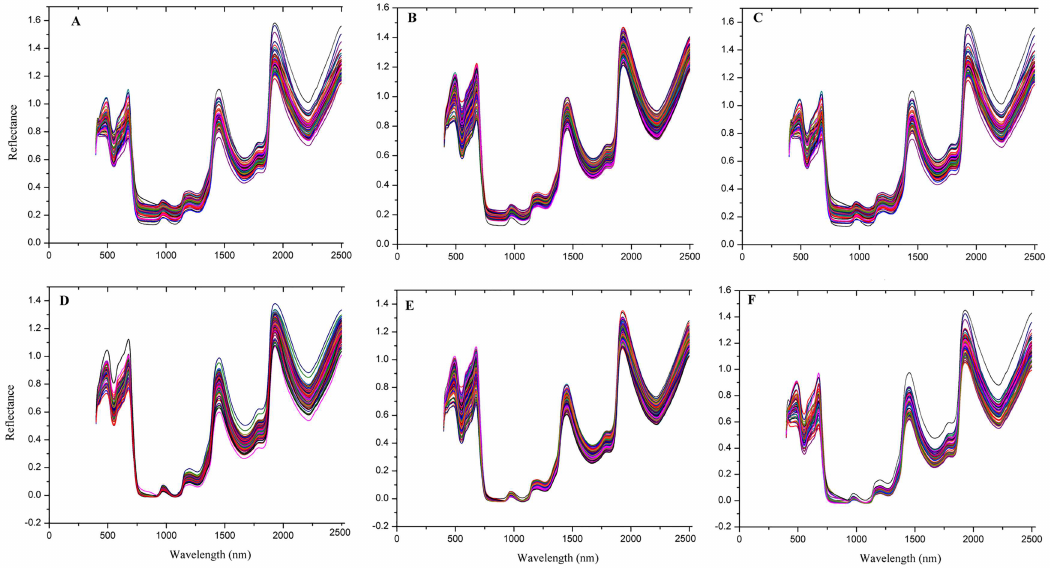
Fig 1. Raw spectra and the spectrawith baseline treatment of Miscanthus varieties. A-C, raw spectra of M . sinensis , M . sacchariflorus and M . fIoridulus ;D-F, the spectra with baselinetreatment of M . sinensis , M . sacchariflorus and M . fIoridulus